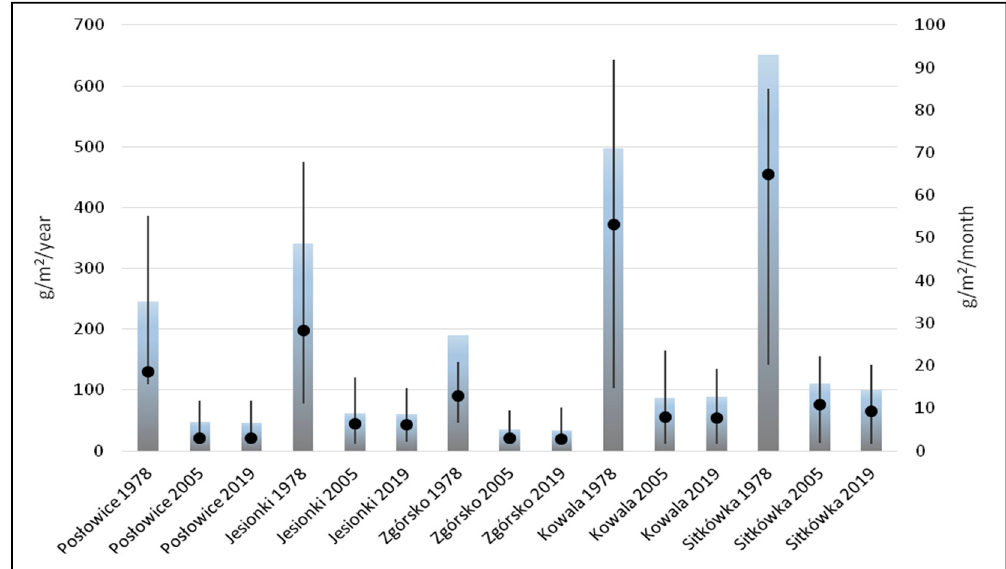
Figure 2. Dynamics of annual and monthly dust fall per g/m 2 in soil profiles at selected research positions in (1) Posłowice, (2) Jesionki, (3) Zgórsko, (4) Kowala, (5) Sitkówka.